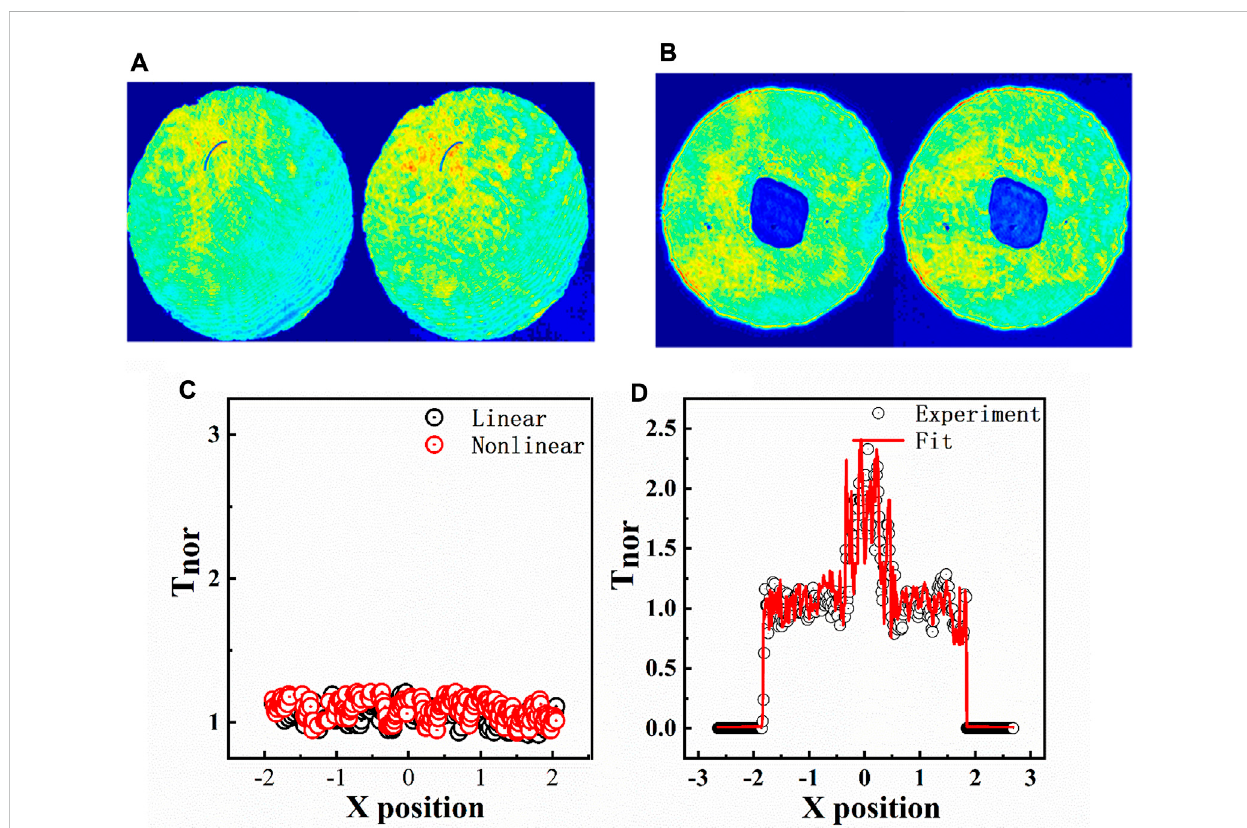
FIGURE 7 (A,B) Linear and non-linear images for ethanol as acquired by our experimental 4f imaging system with a conventional transparent PO and an absorptive (T PO ≈ 16%) HPO. (C,D) Pro fi les of images (A,B) by processing T NL / T L ; the red solid lines are theoretical